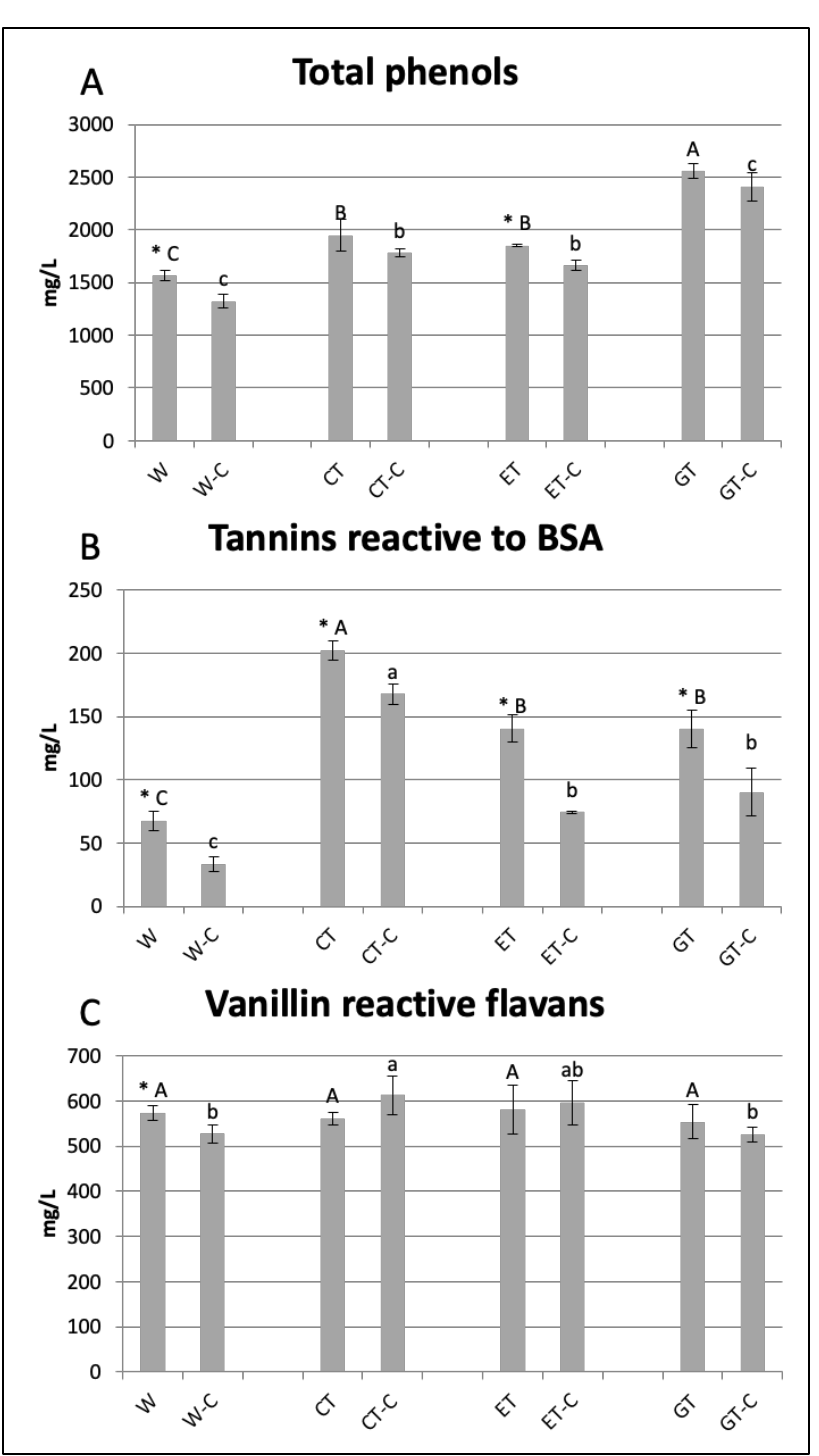
Figure 1. Fining effect on total phenols ( A ), tannins reactive to BSA ( B ), and vanillin reactive flavans ( C ). Different letters indicate a statistically significant difference among treated wines, according to Tukey’s (HSD) analysis ( p < 0.05). The effect of tannin addition is expressed with a capital letter on wines W, CT, ET, and GT (A, B, C), and the effect of chitosan addition is expressed with a lowercase letter on wines W-C, CT-C, ET-C, and GT-C (a, b, c). The asterisk (*) indicates a statistical difference between each kind of wine before and after the treatment with chitosan. All data are expressed as means ± standard deviation.